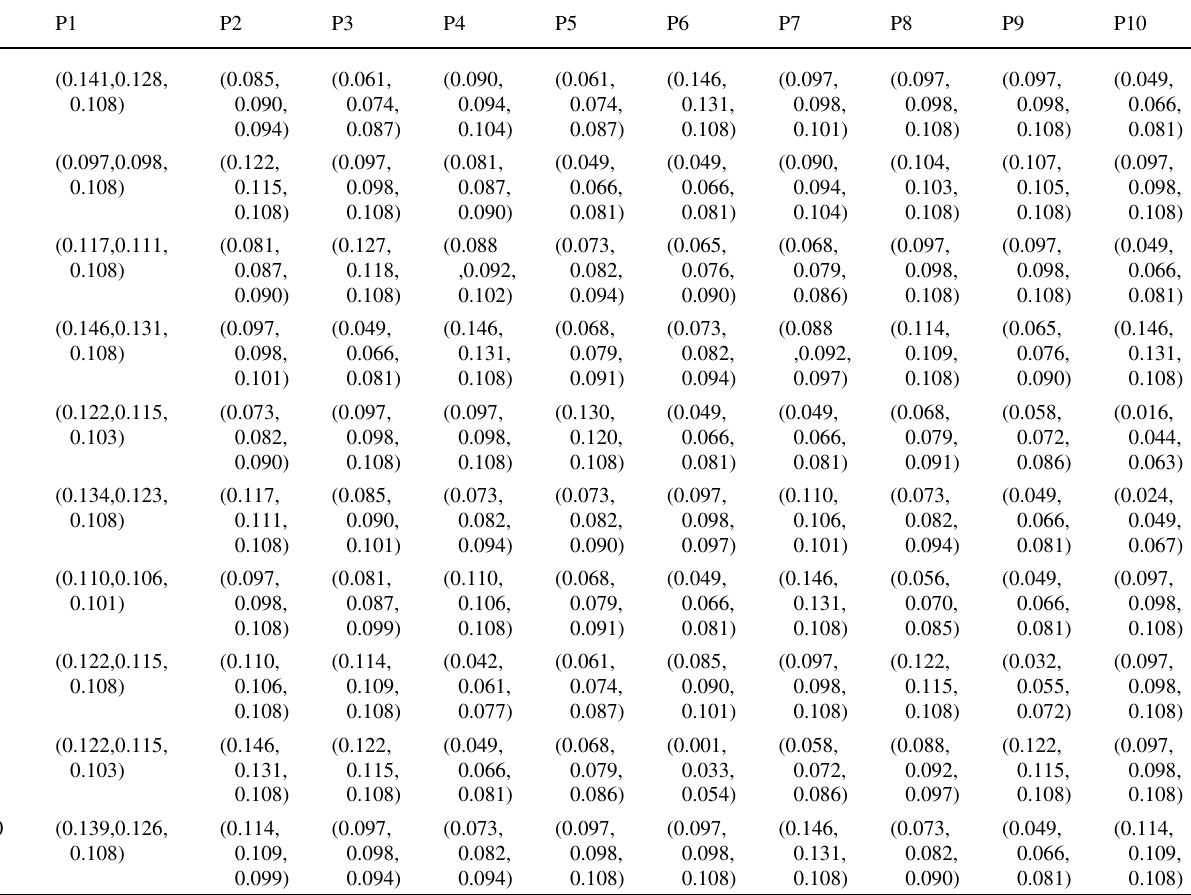
Table 5 Normalized fuzzy strength-influence